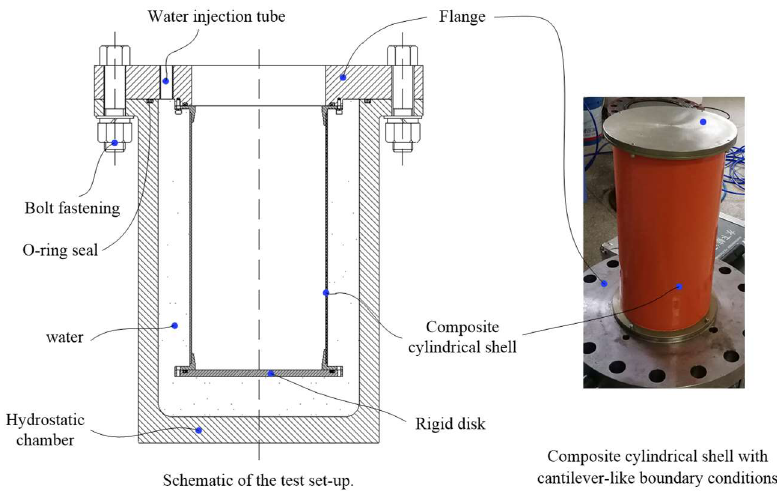
Figure 6. Buckling mode of shell NO.2.